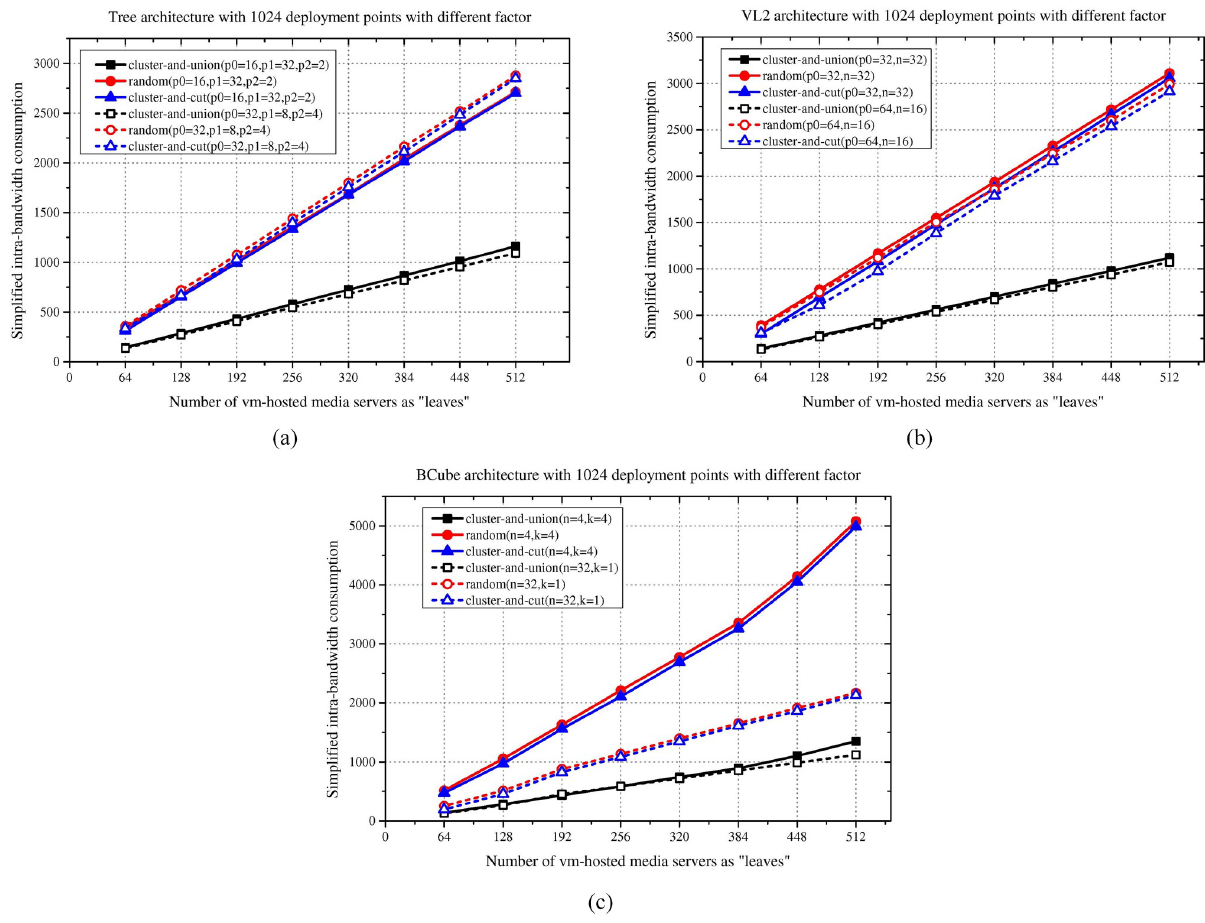
Fig 5. Intra-bandwidth consumption results for different parameters. (a) Tree. (b) VL2. (c) BCube.